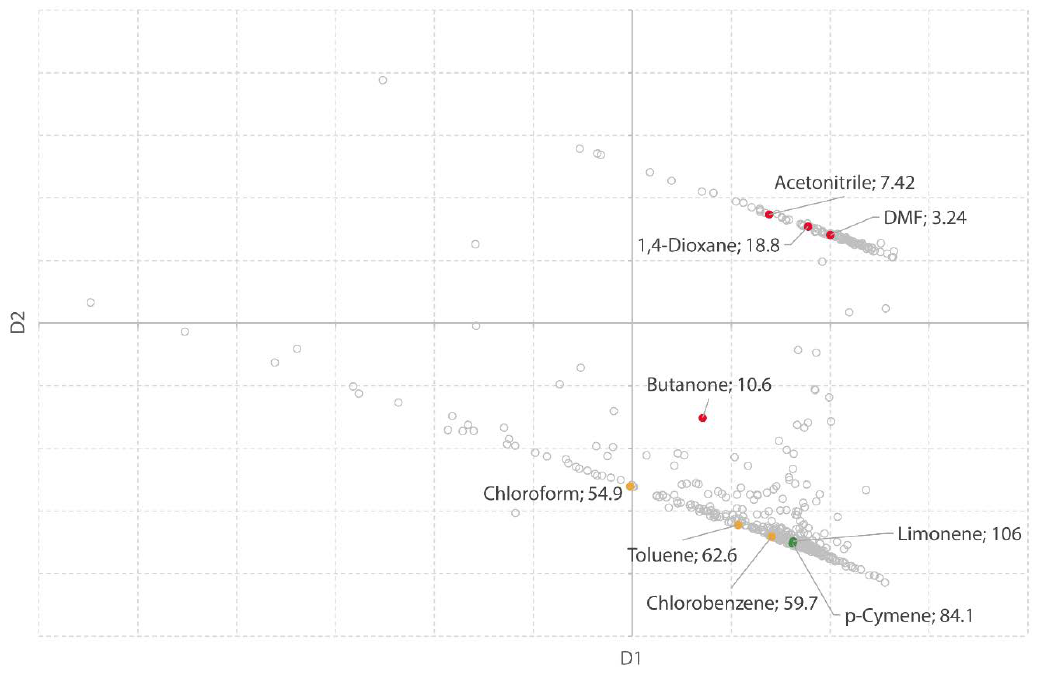
Figure 8. MDS plot with solvents highlighted in green (= high k 2 ), amber (= medium k 2 ), and red